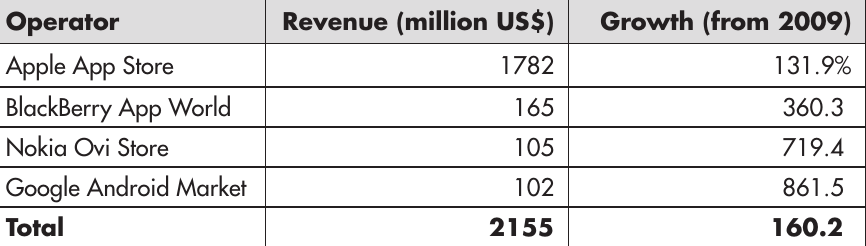
Table 3 Revenues by operating system, 2010